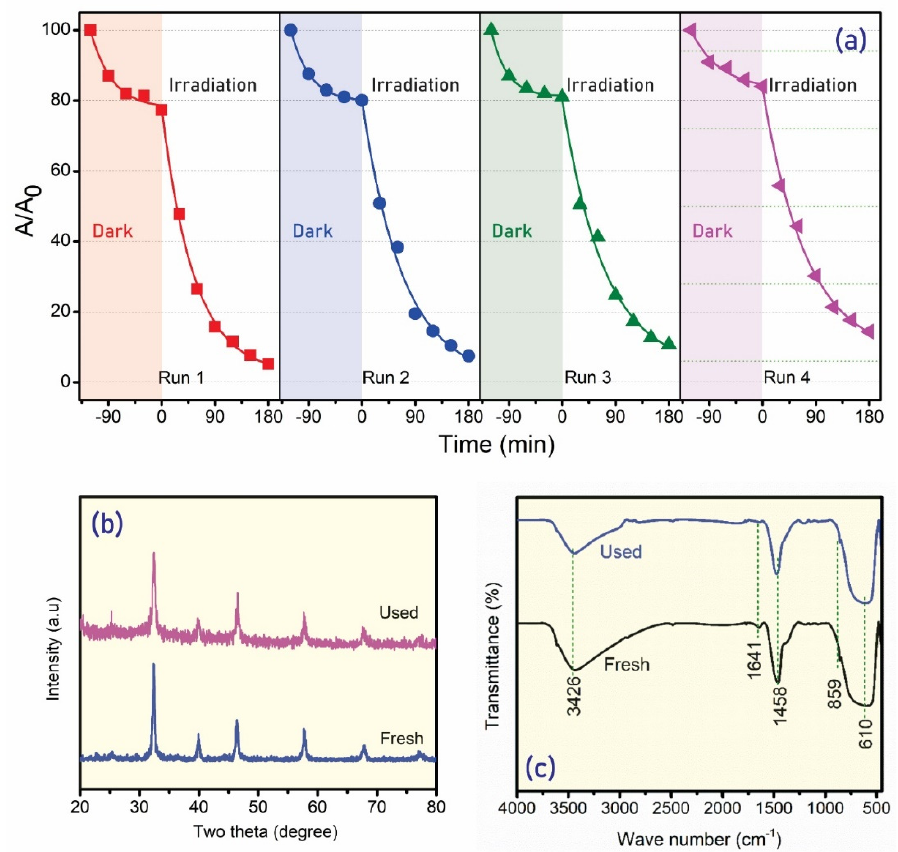
Figure 9. ( a ) Recycling test, ( b ) XRD patterns and ( c ) FTIR spectra of Sr 0.95 La 0.05 TiO 3 powder after the photocatalytic recycling test. Conditions: catalyst, 0.1 g; 2-naphthol (10 ppm, 200 mL); pH 6.3; 30 °C; Exo Terra Natural Light (Repti Glo 2.0 Comp Fluor 26W PT2191-220, Illuminance: 15350 Lux, 400–700 nm).